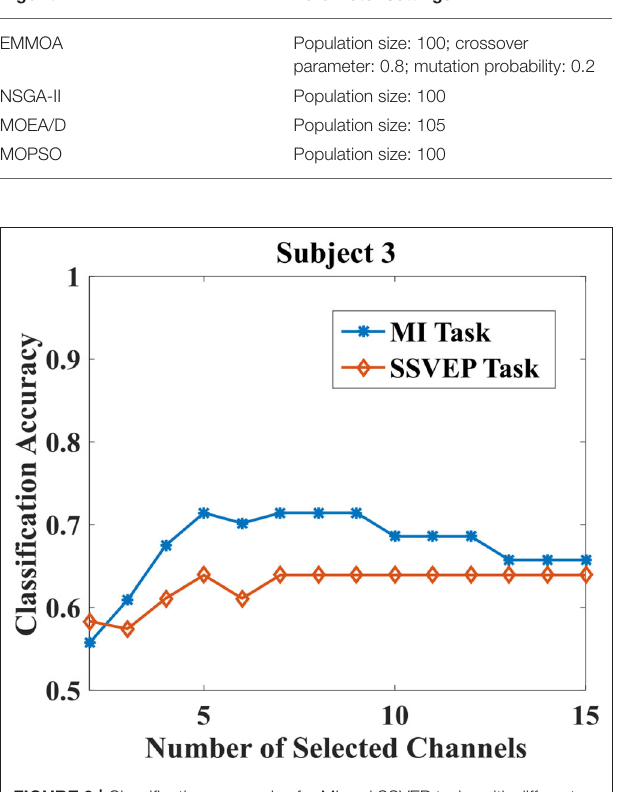
FIGURE 3 | Classification accuracies for MI and SSVEP tasks with different numbers of selected